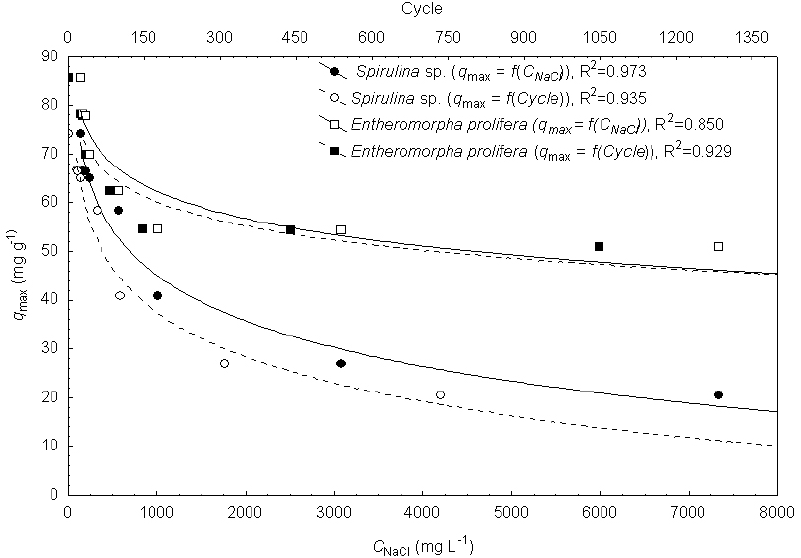
on the amount of released metal ions. max